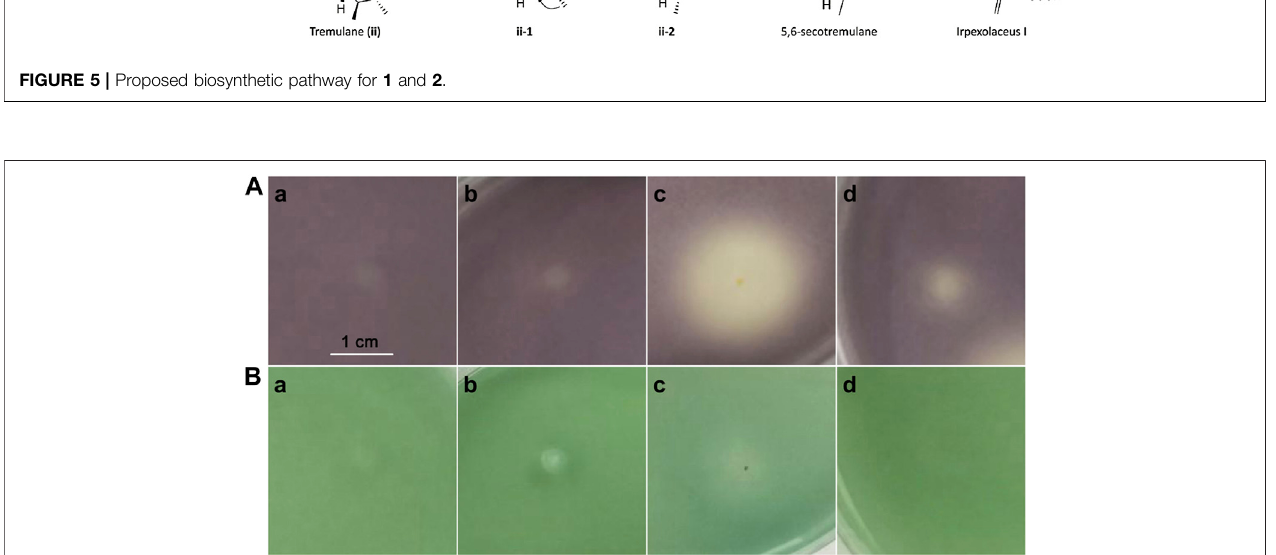
FIGURE 6 | Screening of QS inhibitory activity by C. violaceum CV026 (A) and A. tumefaciens A136 (B) . Compounds 1 (A) , 2 (B) , 3 (C), and 4 (D)